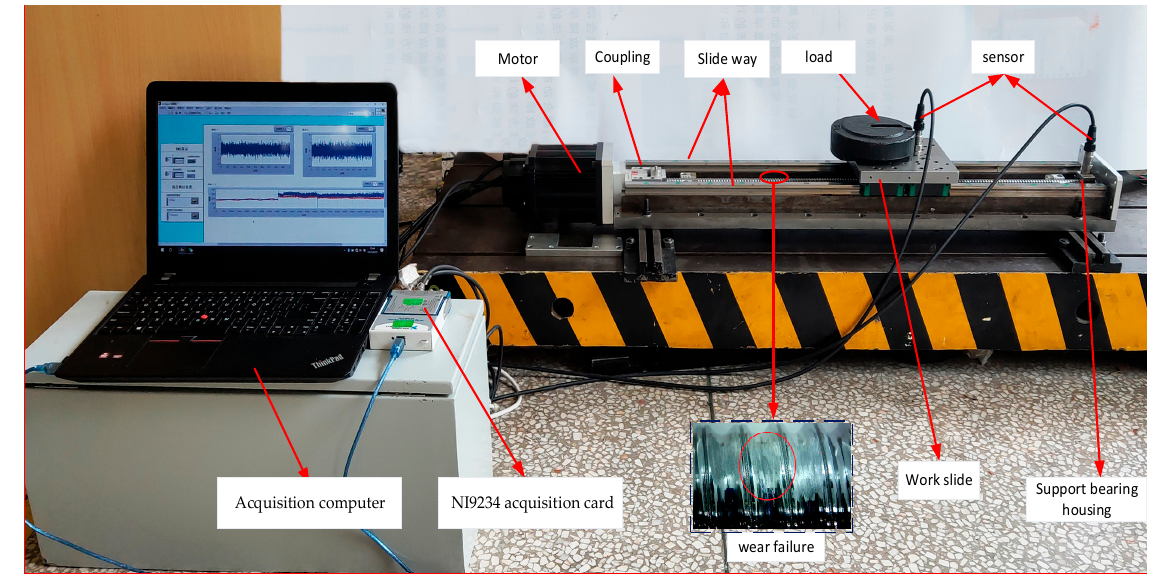
Figure 4. Ball screw test bench. Table 2. Collected data information.